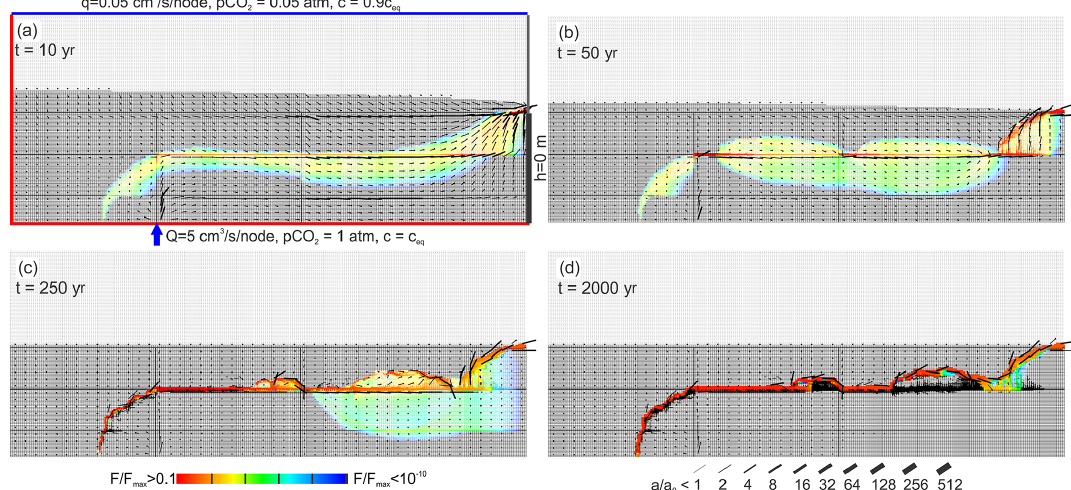
Figure 21. Regular network of prominent fractures of aperture width A 0 = 0 . 05cm embedded in the standard network. Input of deep water is introduced along a single prominent fracture. Everything else as in the standard scenario (Fig.